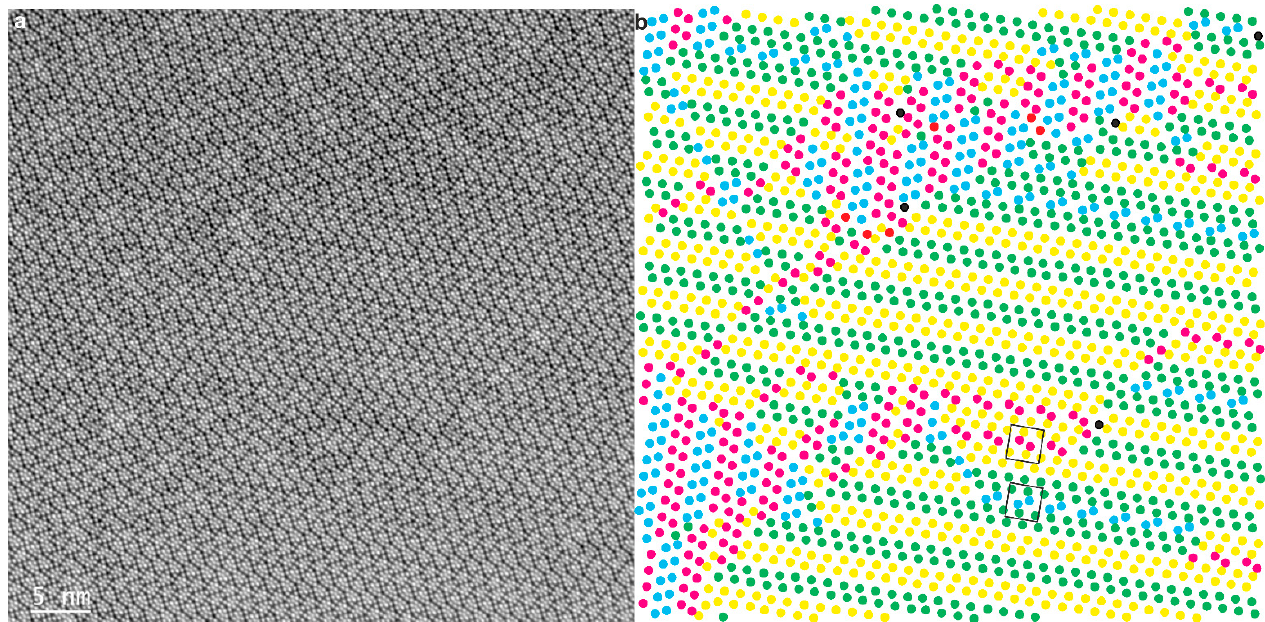
Figure 5. ( a ) HAADF-STEM image (courtesy of Prof. L. Shen, Nanjing) and ( b ) interpretation with PCs shown as filled circles. Two cells of Nb 12 W 11 O 63 in adjacent domains are framed.